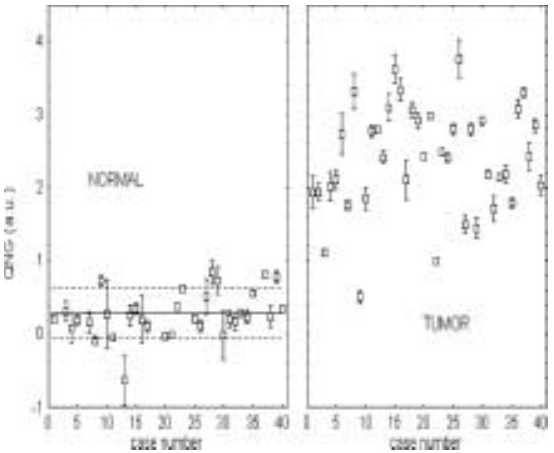
Fig. 4. Reproducibility of quantitative nuclear grade. Minimum and maximum values of the QNG are indicated by the horizontal lines for each case. Variability of measurements of normal cells in this series is indicated by the dashed lines on either side of the mean (solid line), representing ± 1 standard deviation from the